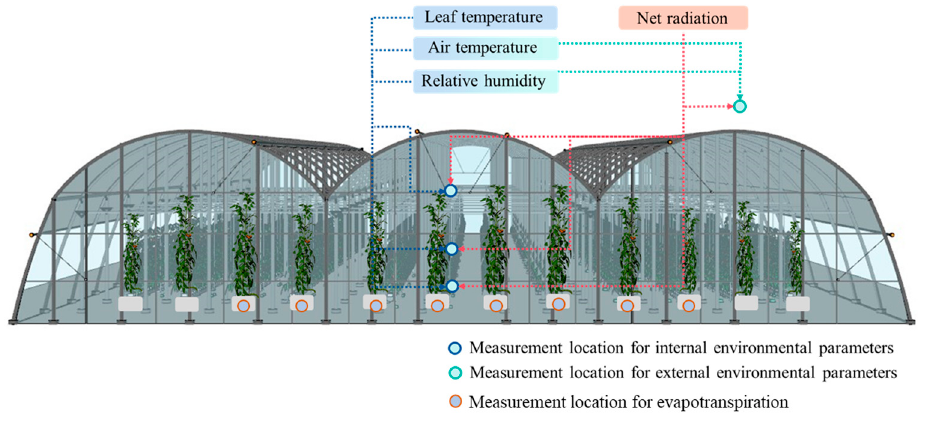
Figure 3. Environmental variables for monitoring the microclimate inside and outside the experimental greenhouse, and sensor installation location for each environmental variable.